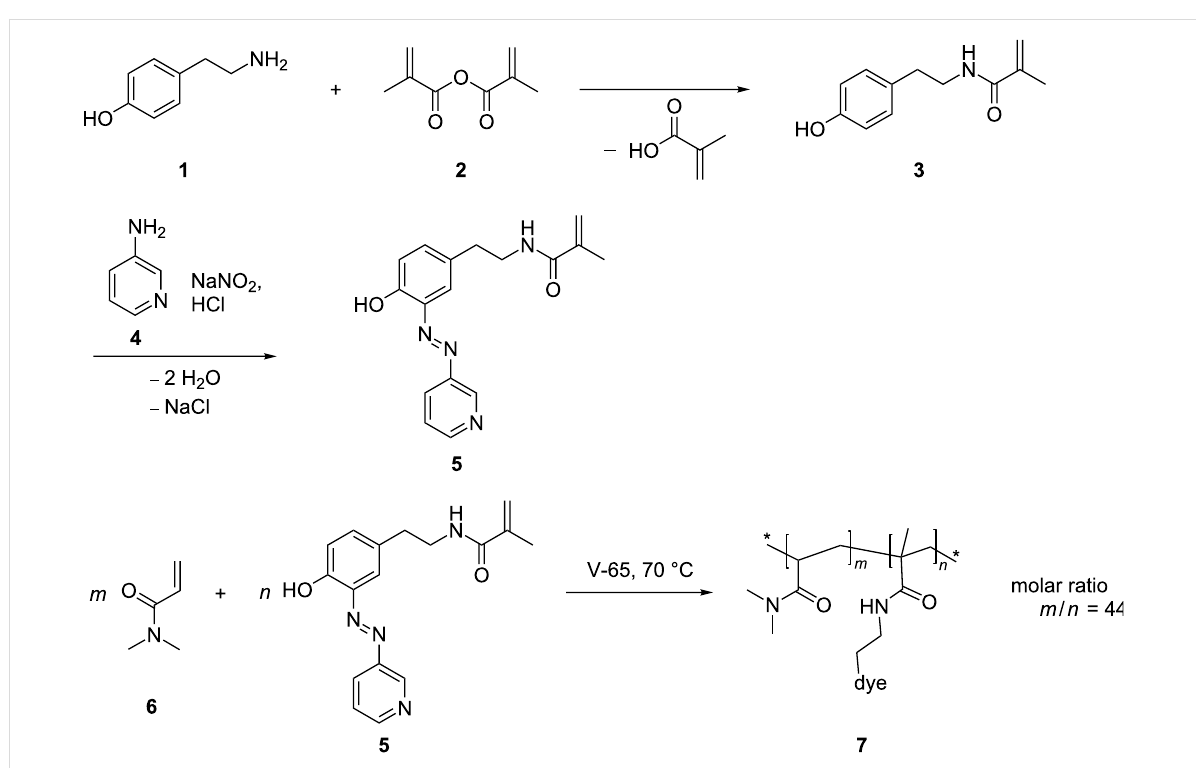
Scheme 1: Synthesis of N -(4-hydroxy-3-(pyridin-3-yldiazenyl)phenethyl) methacrylamide ( 5 ) and preparation of its water-soluble copolymer 7 .